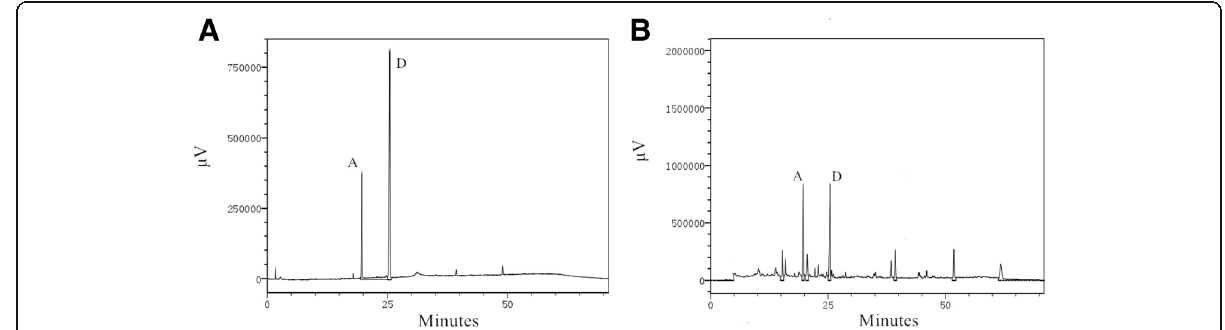
Fig. 1 HPLC chromatograms. a Standard mix and b Alcohol elution of SS. SSa and SSd were indicated by “ A ” and “ D ” ,